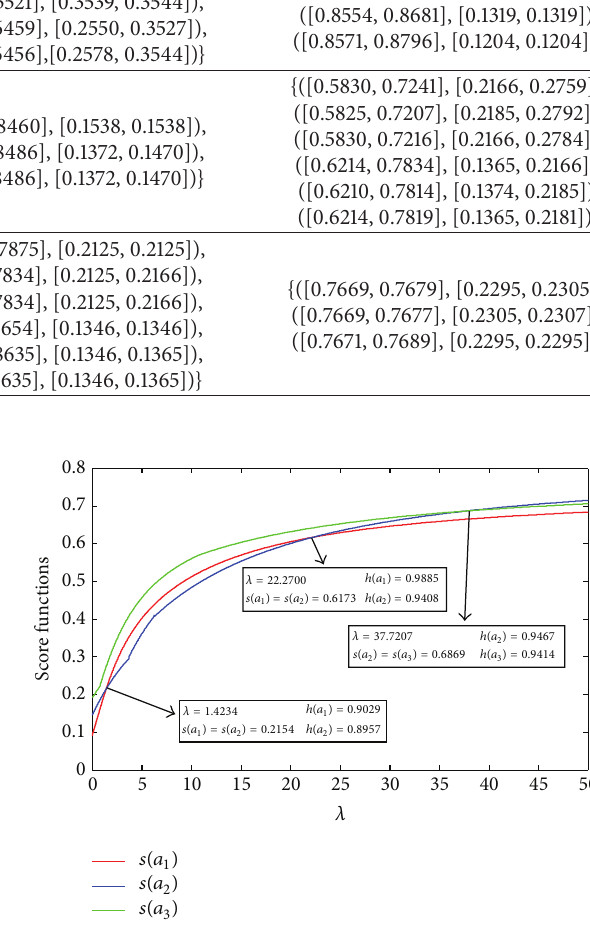
Figure 1: Variation of the score functions with respect to the parameter 𝜆